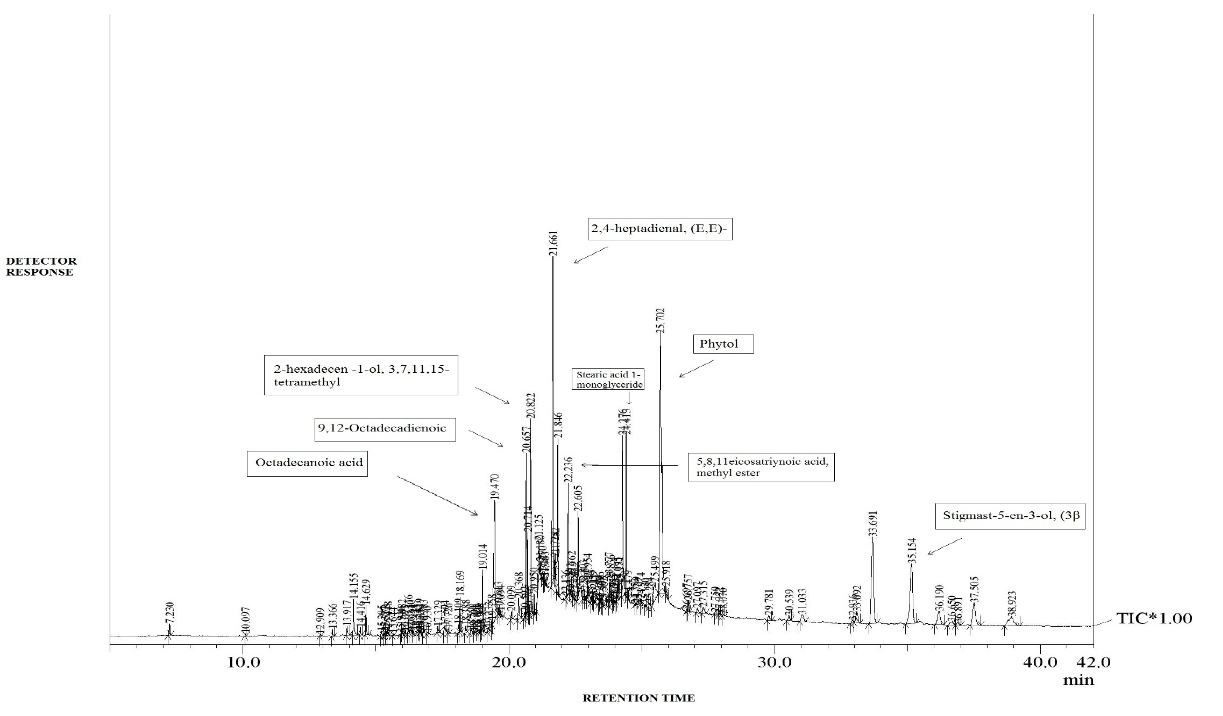
FIGURE 2 – Methanol extract chromatogram. TABLE I - C hemical composition of hexane extract of whole plant of A. uliginosa